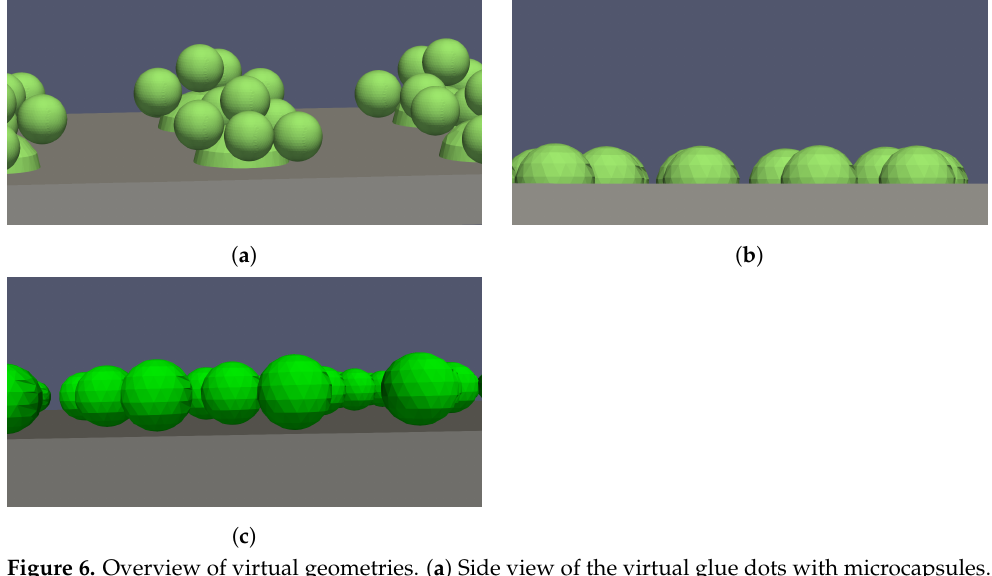
Figure 6. Overview of virtual geometries. ( a ) Side view of the virtual glue dots with microcapsules. ( b ) Side view of the virtual microcapsules partly subsiding in the membrane. ( c ) Side view of the virtual microcapsules with idealized point contact on the membrane